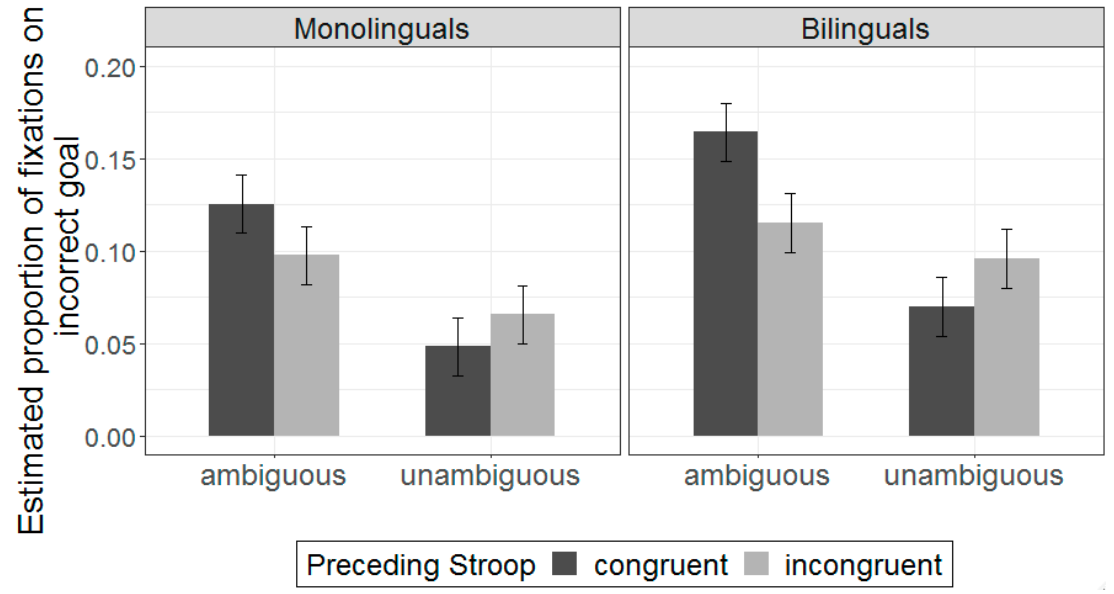
Figure 3. Estimated effects for incorrect-goal fixations for ambiguous sentences as a function of prior Stroop trial type. Higher values on the y-axis indicate more looks to the incorrect goal object (e.g., an empty napkin). Fixations were averaged from the onset of the second noun phrase through the action period. Error bars indicate standard error of the mean.